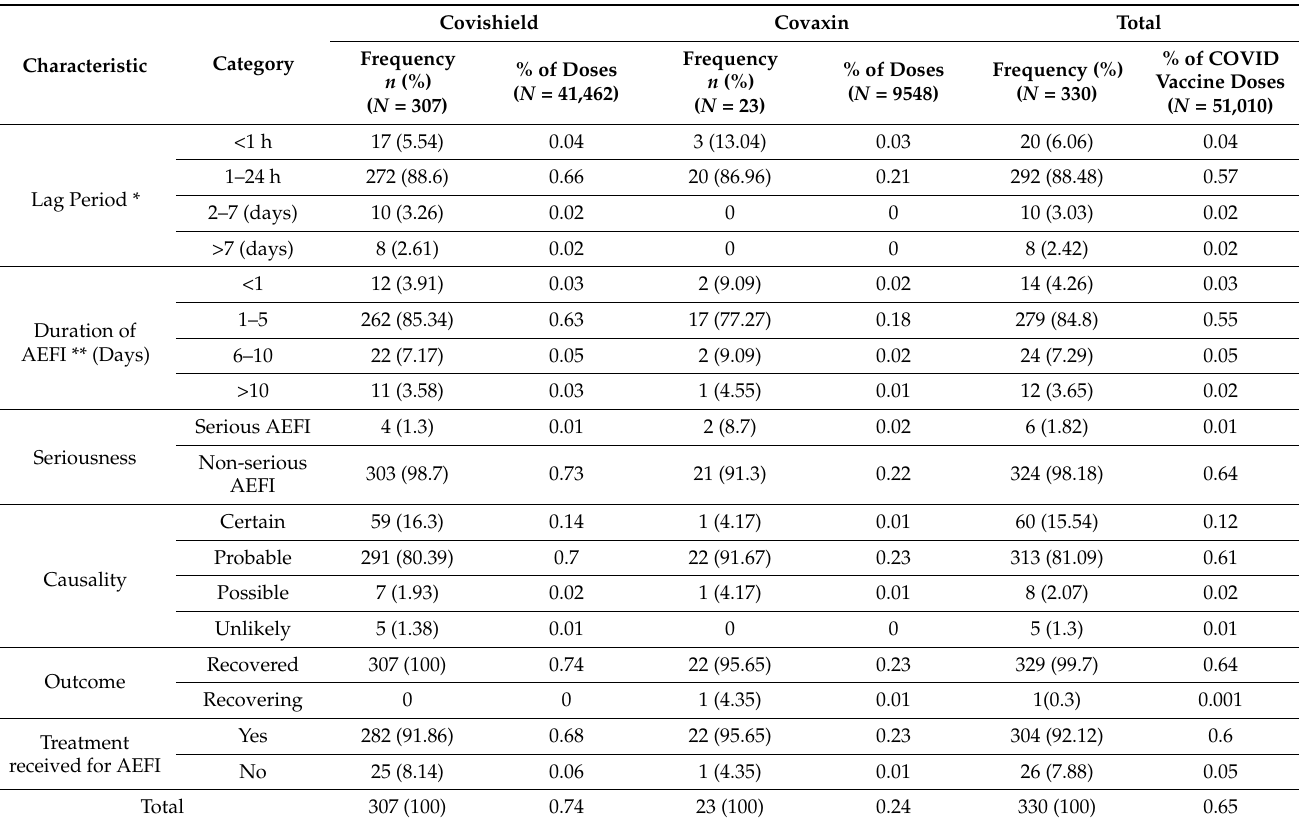
Table 2. Characteristics of AEFI reported with COVID-19